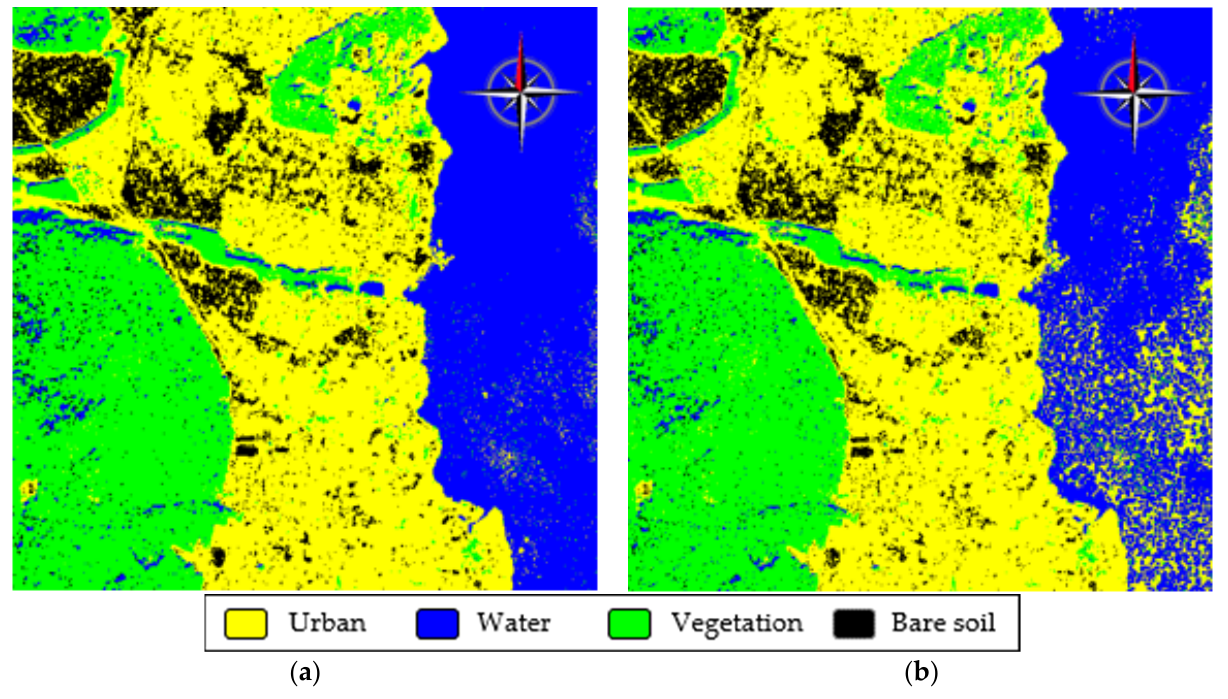
Figure 18. Classification maps for images compressed by DAT of depth 1 with MAD = 4 ( a ) and MAD = 16 ( b ). Table 7. Probabilities for classes and total probabilities of correct classification for depth 2 and dif- ferent MAD.